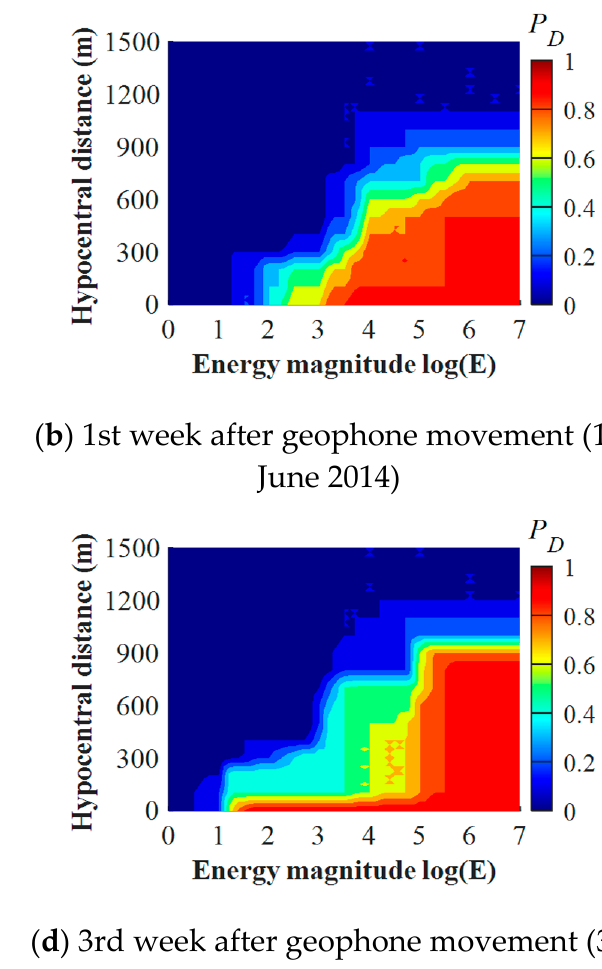
9 of 18 Figure 6. Number of seismic events used for weekly 𝑃 (cid:3005) calculation for different geophones be- tween 12 April and 12 May 2014. To investigate the 𝑃 (cid:3005) evolution characteristics over geophone movement, the 𝑃 (cid:3005) results for Geophone #2 were calculated before and after its movement on 5 July 2014. The results are shown in Figure 7. For the last 𝑃 (cid:3005) result before the movement (Figure 7a), Geophone #2 presented a significant sensitivity to seismic events with a wide energy range. For the 1st week after the movement (Figure 7b), Geophone #2 showed a de- creasing detection capacity for detecting seismic events with logE < 3 and hypocentral distances larger than 300 m. During the 2nd and 3rd weeks (Figure 7c,d), although Ge- ophone #2 presented an enhancing detection capacity in detecting high-energy events